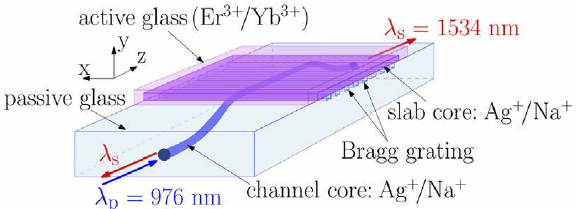
Figure 7. Sketch of a hybrid distributed feedback (DFB) laser constituted by a channel core waveguide, buried in the silicate substrate by and loaded by a slab core waveguide in an Er/Yb-co-doped glass. Both waveguides are made by ion exchange. Reproduced with permission of Elsevier from [60].